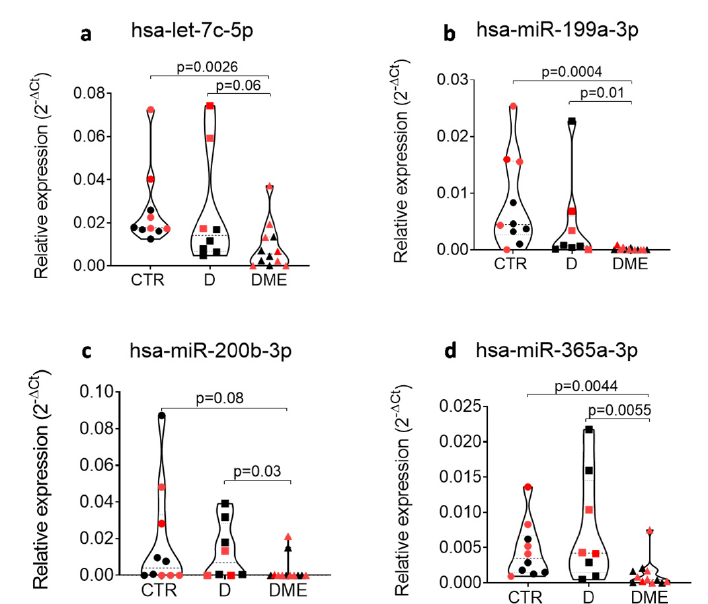
Figure 5. The expression of hsa-let-7c-5p ( a ), hsa-miR-199a-3p ( b ), hsa-miR-200b-3p ( c ) and hsa-miR- 365-3p ( d ) is reduced in AH of DME vs CTR and/or vs D patients after testing for all subjects included in the study ( n = 10 CTR, n = 8 D, n = 12 DME). Profiling cohort ( n = 5 CTR, n = 5 D, n = 5 DME) is indicated with black dots, while the additional validation cohort ( n = 5 CTR, n = 3 D, n = 7 DME) is shown as red dots. microRNA expression values are reported as 2 −Δ CT normalized for the expression of hsa-miR-150-5p. Median values for each group are shown as dotted line alongside with quartiles (smaller dotted lines). p -values were considered significant with p < 0.05 using Mann–Whitney U Test.